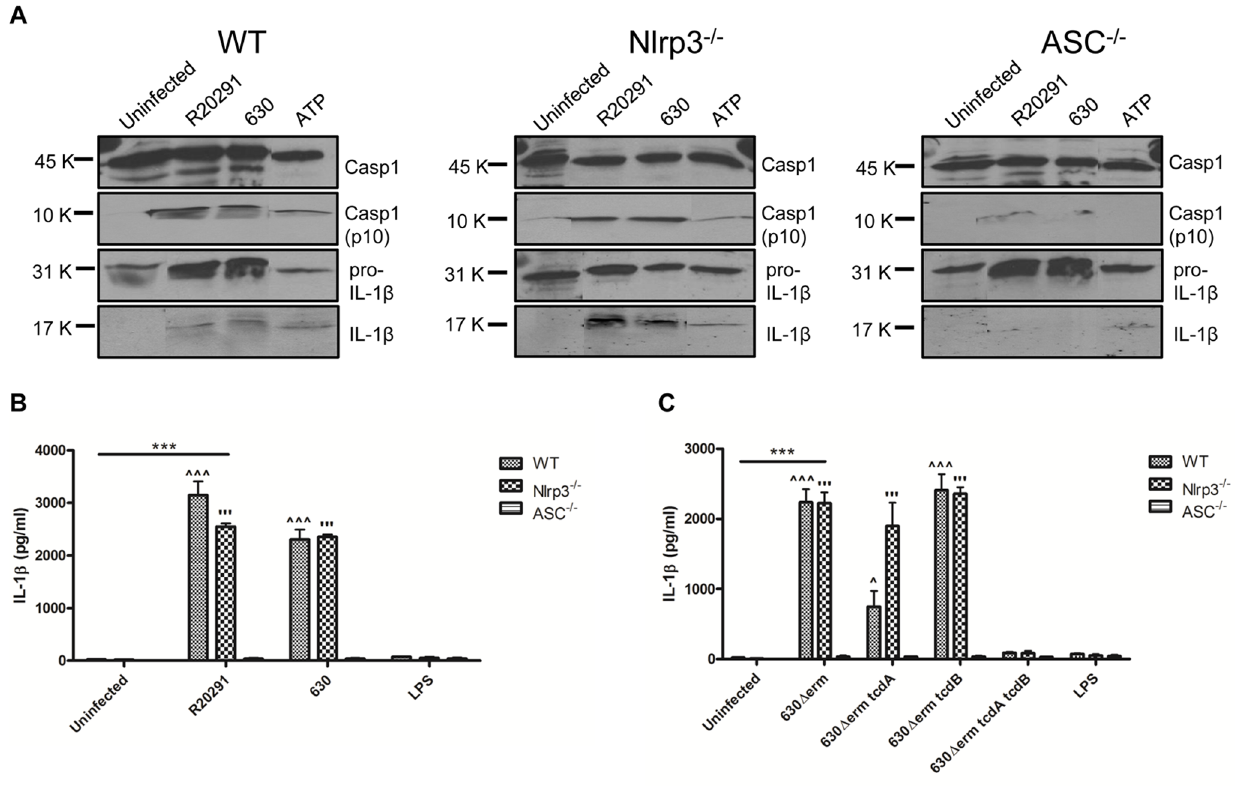
Figure 4. C.difficile toxins trigger BMDC IL-1 b release by activating an ASC-containing inflammasome. BMDCs from WT C57BL/6 (genetically Nlrp1 deficient) mice and mice deficient in Nlrp3 and ASC were infected with C. difficile strains at an MOI of 10. Pro- and active caspase-1 (45 & 10 kDa, respectively) and pro- and mature IL-1 b (31 & 17 kDa, respectively) release 8h post-infection was quantified by western blotting. 5 mM ATP served as a positive control (A). Quantification of IL-1 b secretion in infected WT, Nlrp3 and ASC KO BMDC 8h post-infection. Data is represented as mean 6 SEM, n=4. ***p , 0.001 represents significant difference from uninfected cells, ‘ p , 0.05 and ‘‘‘ /’p , 0.001 represent significant WT and Nlrp3 2 / 2 difference from ASC 2 / 2 . P values were obtained using ANOVA with Bonferroni post-test analysis (B & C).